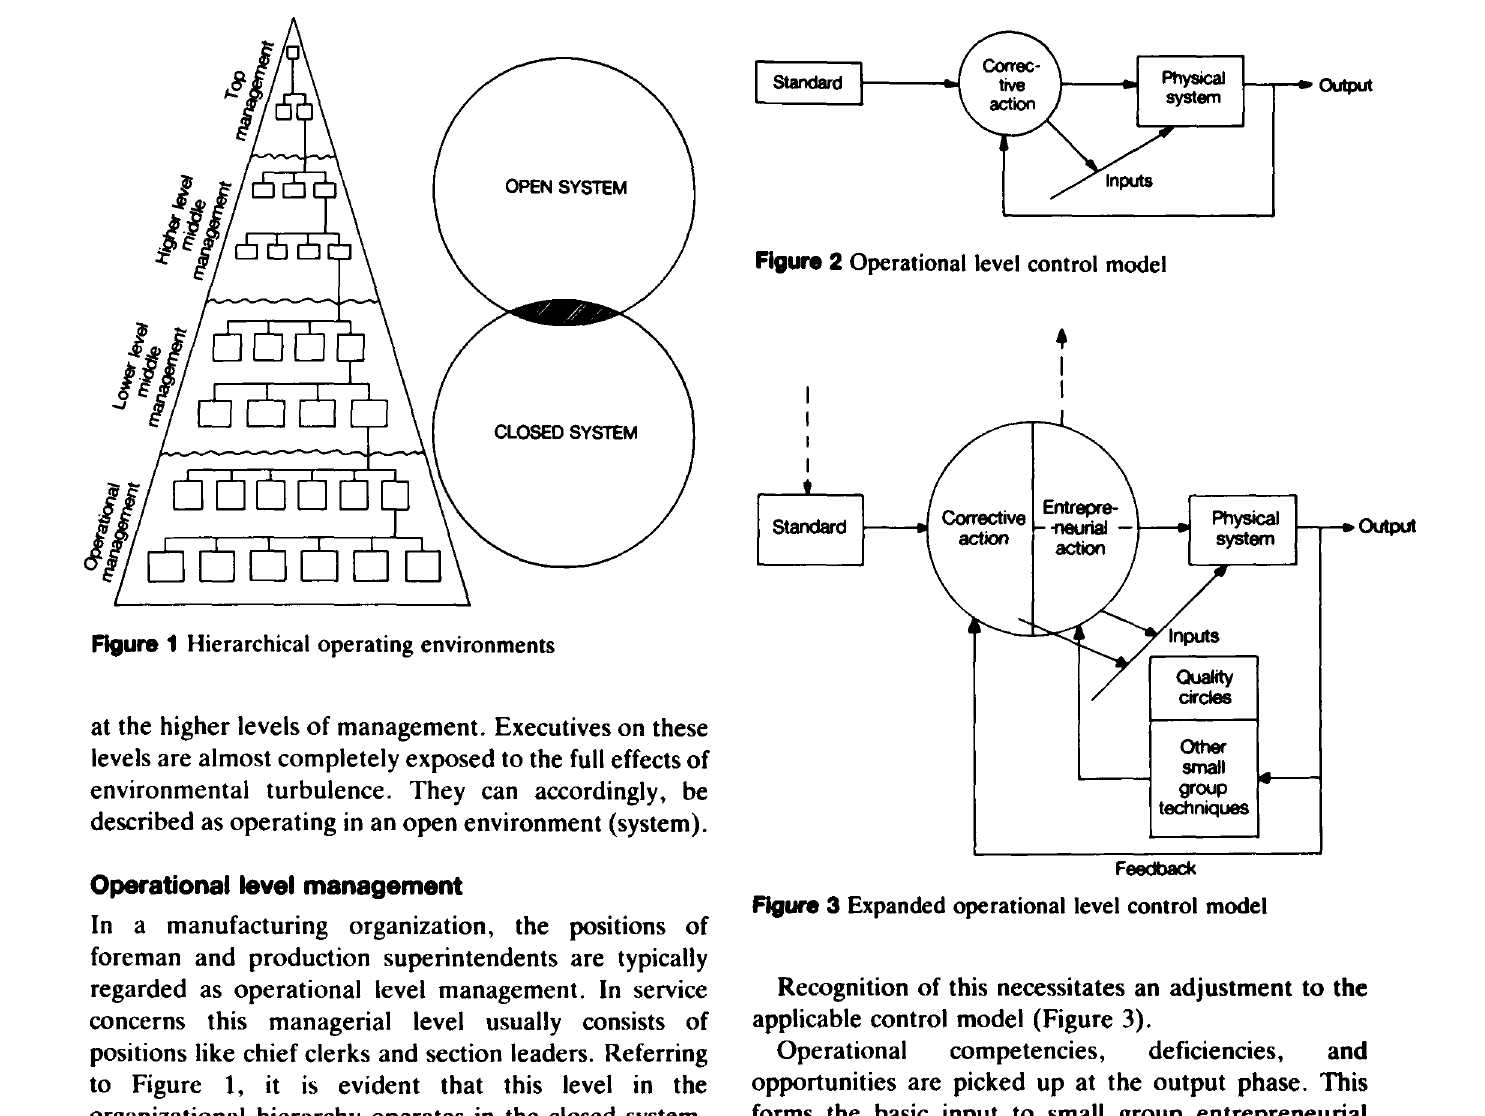
Figure 1 Hierarchical operating